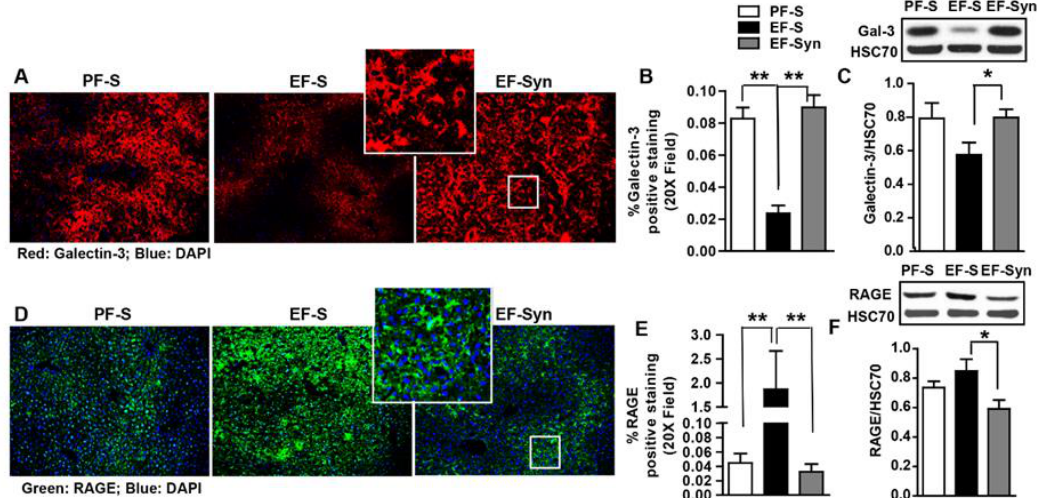
Figure 4. Hepatic expression of advanced glycation end-product (AGE) receptors. Mice were